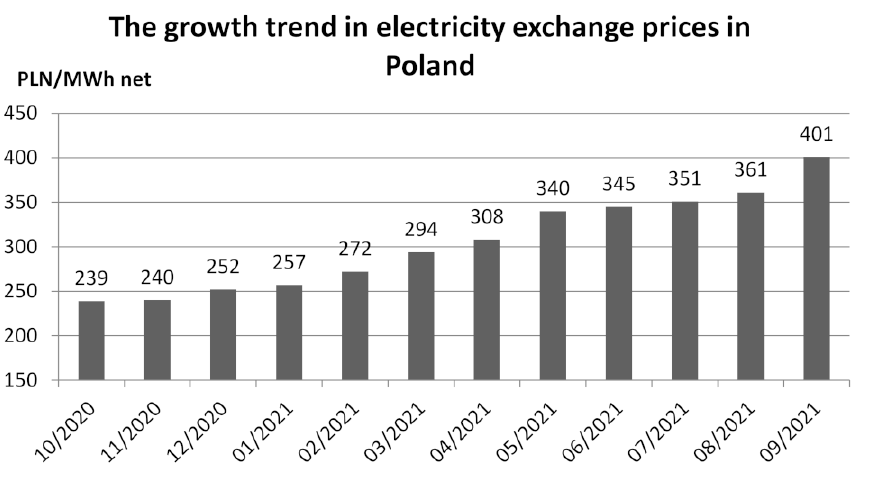
Figure 3. The growth trend in electricity exchange prices in Poland is October 2020–September 2021 [45].